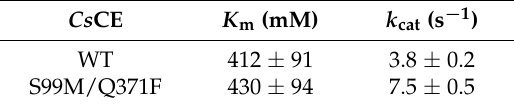
Figure 4. The catalytic Trp residue in the active sites of Rm CE (carbon in green, nitrogen in blue, sulfur in yellow) (PDB code: 3WKG) and Cs CE (carbon in yellow, nitrogen in blue, oxygen in red) (PDB code: 4Z4J) has a slightly different orientation towards the glucose moiety of glucosylmannose (carbon in cyan, oxygen in red). In the active site of Rm CE, Trp-385 is oriented closer to glucose, probably due to the accompanying resides Phe-384 and Met-109. Table 4. Kinetic parameters of cellobiose 2-epimerase from C. saccharolyticus for D -mannose, both for wild-type and double mutant S99M/Q371F. Tests were performed at pH 7.5 and 70 °C. Data represent the mean of three experiments with standard error.